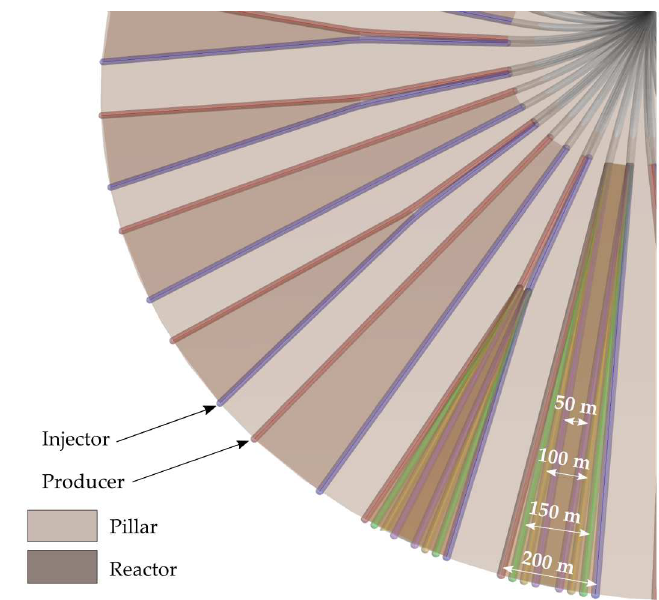
Figure 7. Gasification channel design for different channel widths (50 m–200 m).